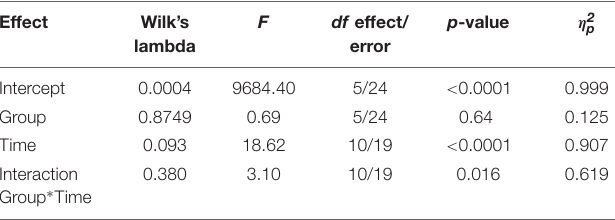
TABLE 2 | Full multivariate model of RM ANOVA with all variables covering the left side of the body.